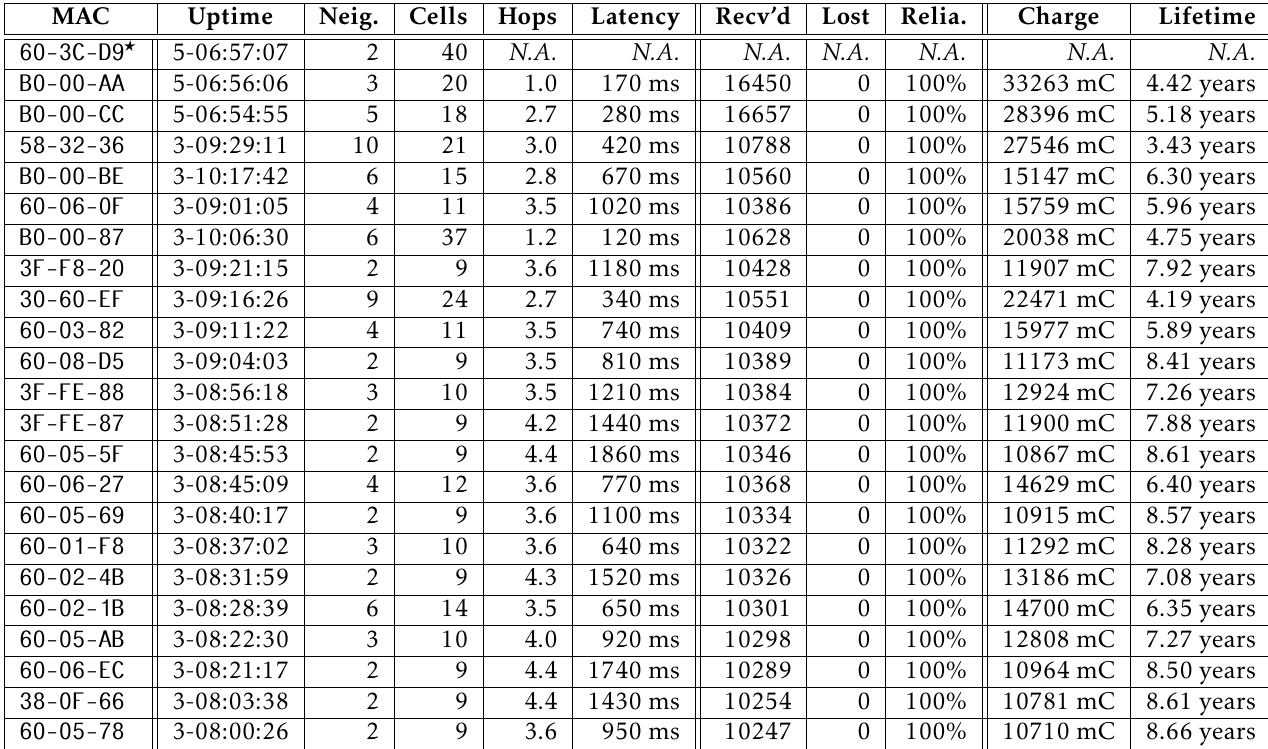
Table 2. Key mote performance